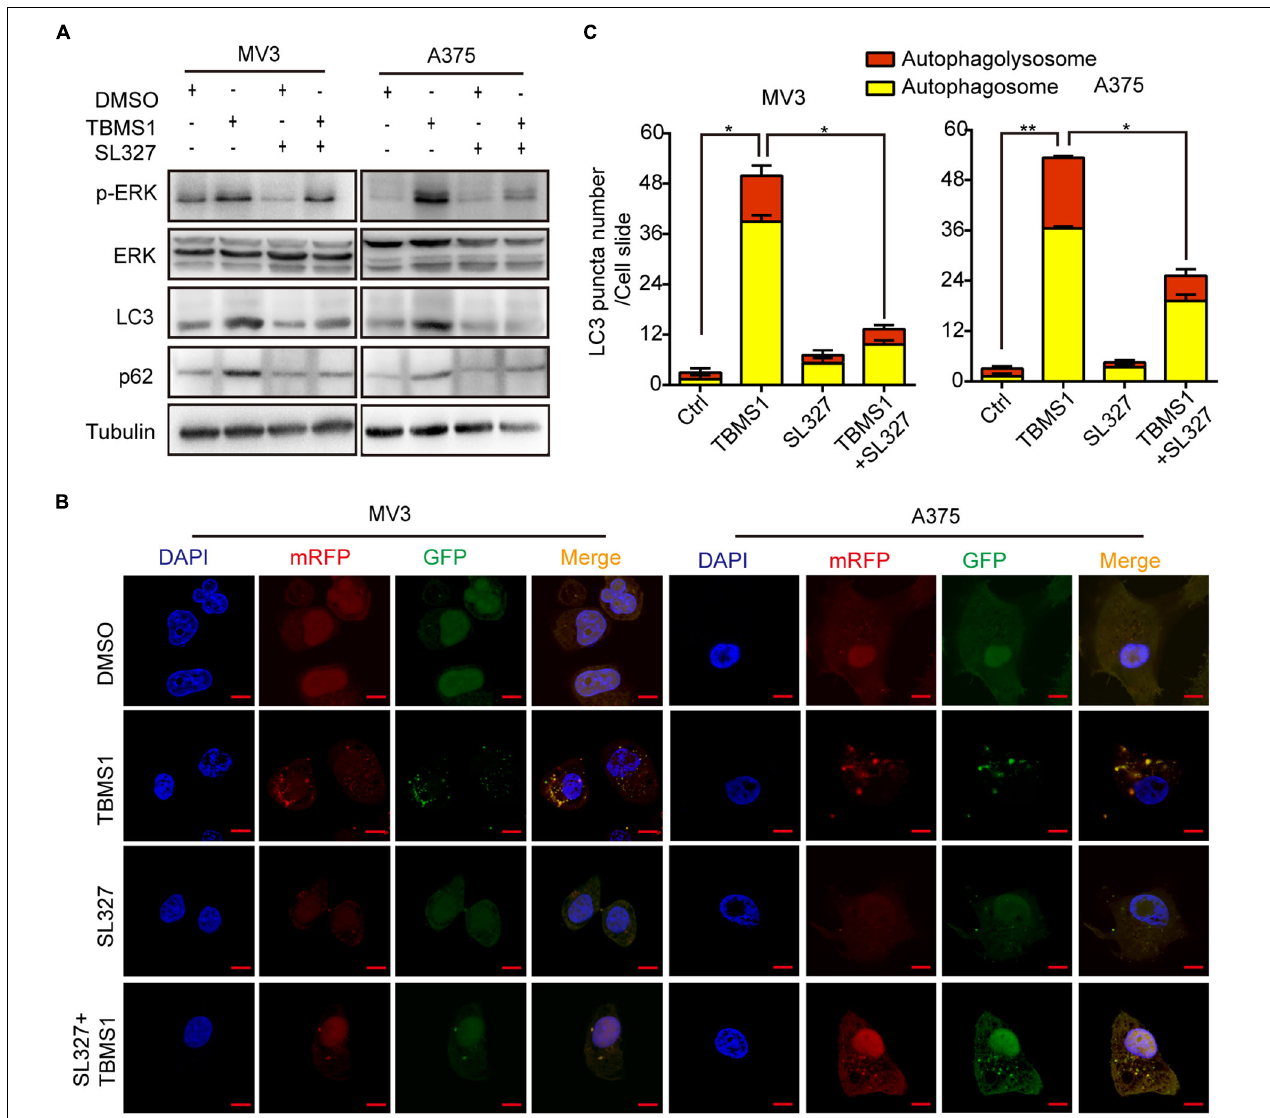
FIGURE 5 | TBMS1-induced autophagy is mediated by hyperactivation of MEK1/2-ERK1/2 cascade. (A) Western blot was performed to detect the expression levels of p-ERK1/2, ERK1/2, p-MEK1/2, MEK1/2, LC3B, and p62 in melanoma cells treated with TBMS1 for 48 h. (B,C) After transfected with mRFP-GFP-LC3 plasmids, the level of autophagy was tested by immunofluorescence staining assay in MV3 and A375 cells treated with TBMS1 and 1.25 µ M SL327 for 48 h. The yellow (autophagosomes) and red signals (autophagolysosome) in every cell per slide were calculated. A two-tailed unpaired Student’s t -test was carried out. * p < 0.05, ** p <